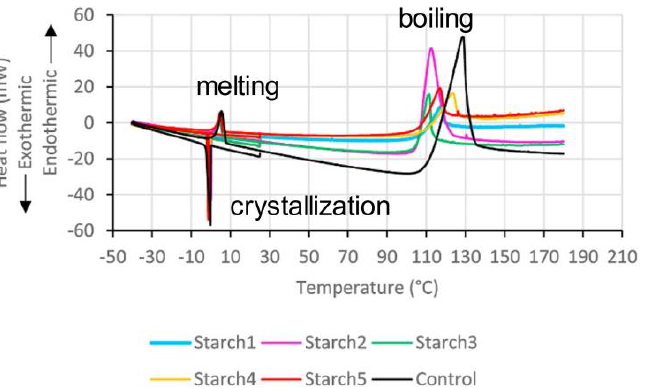
Figure 8. DSC signals for milk samples adulterated with various amount of starch [40]. Thermal processes that take place during cooling and subsequent heating are indicated. Reprinted with permission from Elsevier. Table 3. Thermal properties derived from the DSC data for various milk samples [40]. Reprinted with permission from Elsevier.